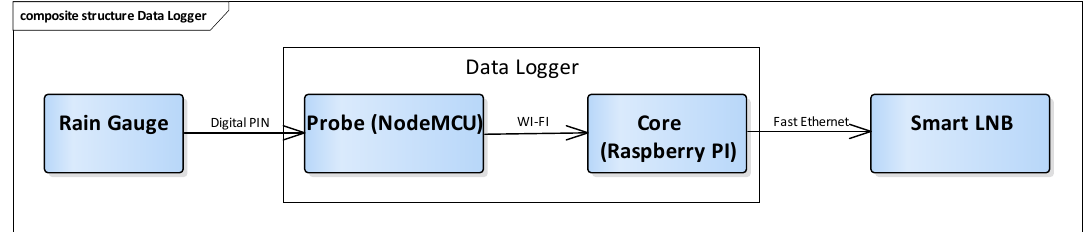
Figure 4. Architecture of the Earth station rain gauge sensor.